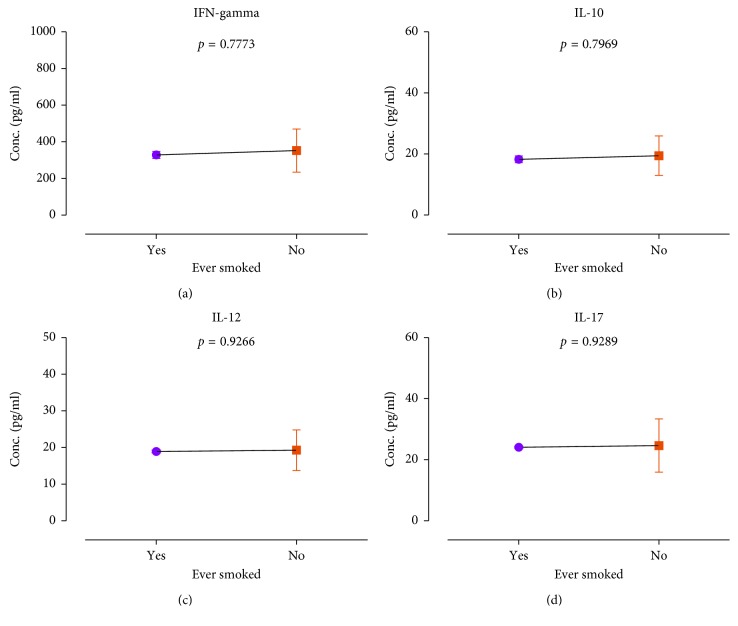
Association of smoking with cytokine distribution: (a) IFN-gamma, (b) IL-10, (c) IL-12, and (d) IL-17.